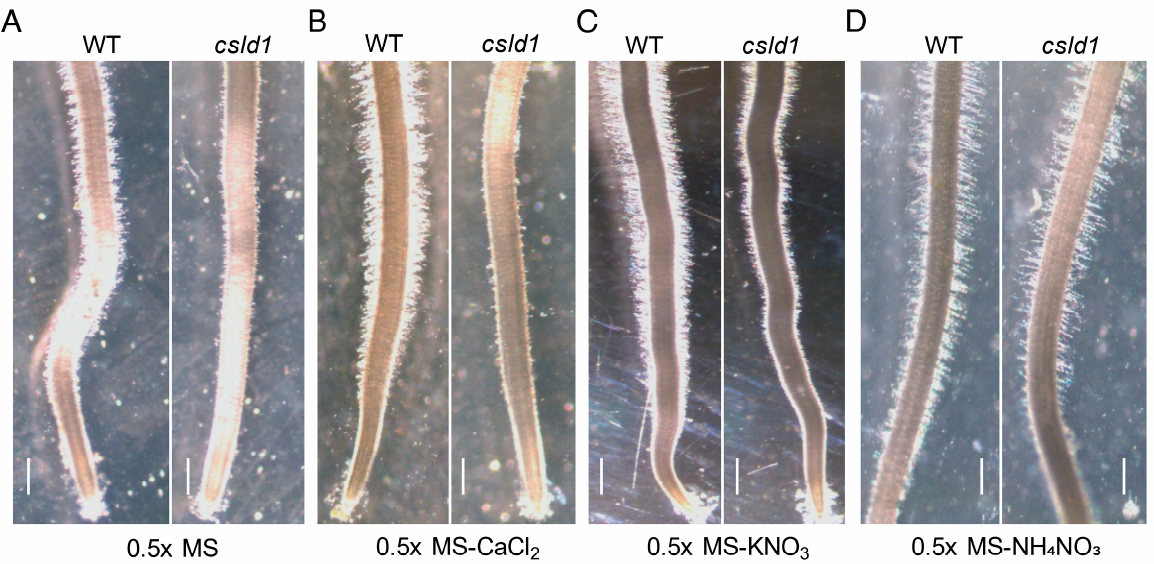
Figure 1. The csld1 mutants were recovered under nitrogen depletion. Root hair length of wild-type (WT) and oscsld1 RNAi mutants grown in ( A ) Half-MS medium, ( B ) Half-MS medium without CaCl 2 , ( C ) Half-MS medium without KNO 3 , and ( D ) Half-MS medium without NH 4 NO 3 . Scale bars = 500 μ m.